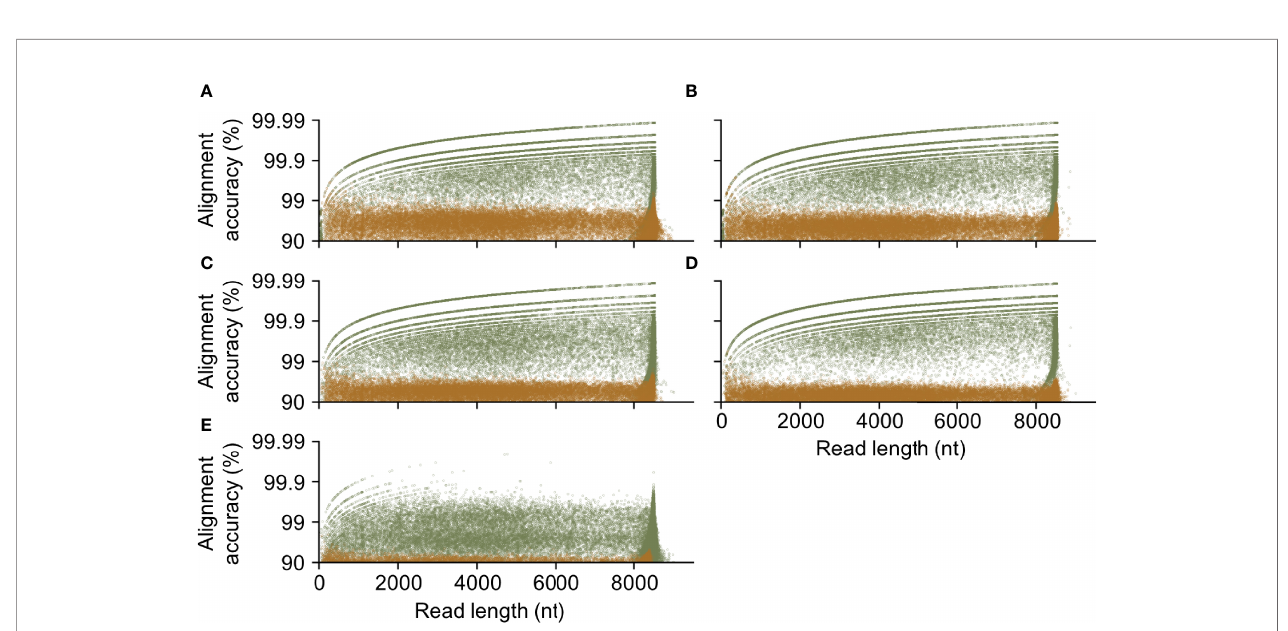
FIGURE 7 | HIV-Quasipore yielded highly accurate long reads. The relationship between length and alignment accuracy of a read was plotted for (A) R9.4.1 SUP, (B) R10.3 SUP, (C) R9.4.1 HAC, (D) R10.3 HAC, and (E) R9.4.1 fast pretrained and HIV-Quasipore basecallers. Each point corresponds to a single read with an alignment accuracy ≥ 90%. Brown and green points correspond to the pretrained and HIV-Quasipore basecallers, respectively.